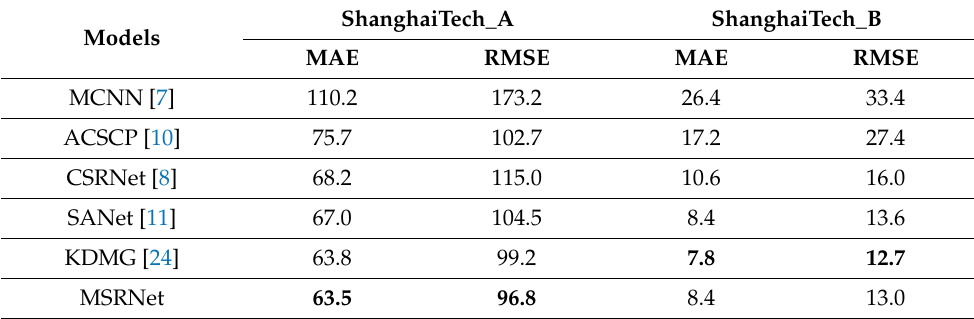
Table 3. Estimation error on the ShanghaiTech